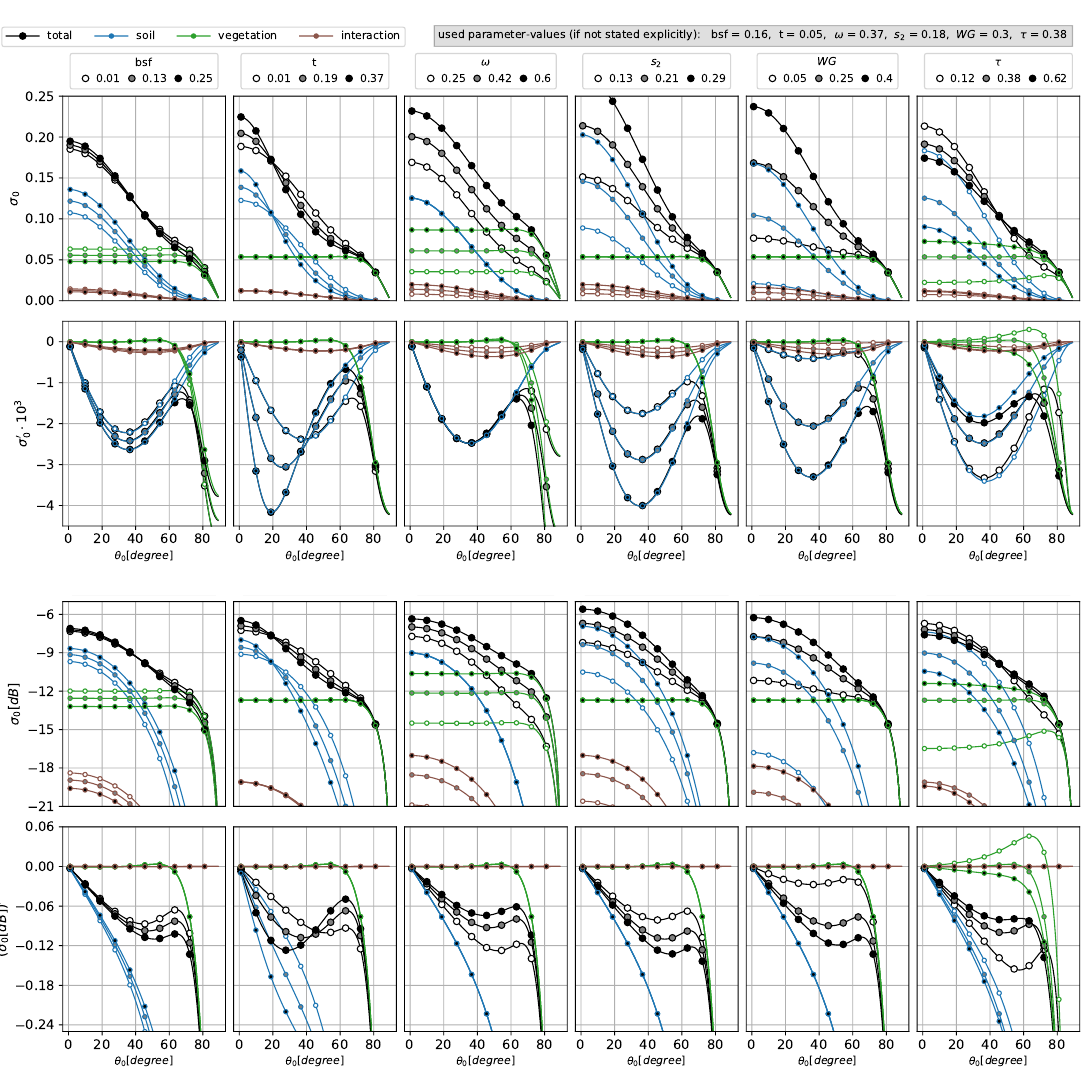
Figure 7. Illustration of the behaviour of modelled σ 0 as well as the resulting soil-, vegetation- and interaction-contributions and the corresponding slopes σ (cid:48) the model-parameters in linear- ( top ) and dB ( bottom )